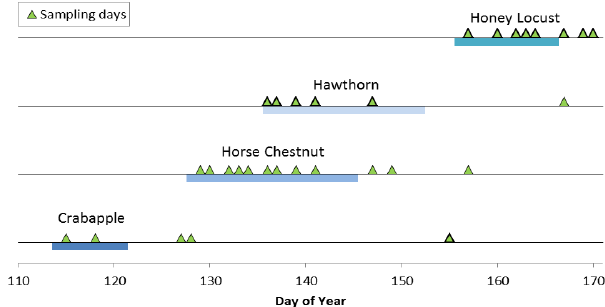
Fig. 2. Blooming periods (marked in blue) for crabapple, horse chestnut, hawthorn, and honey locust trees investigated in 2009. Sample collection days are shown by green triangles.